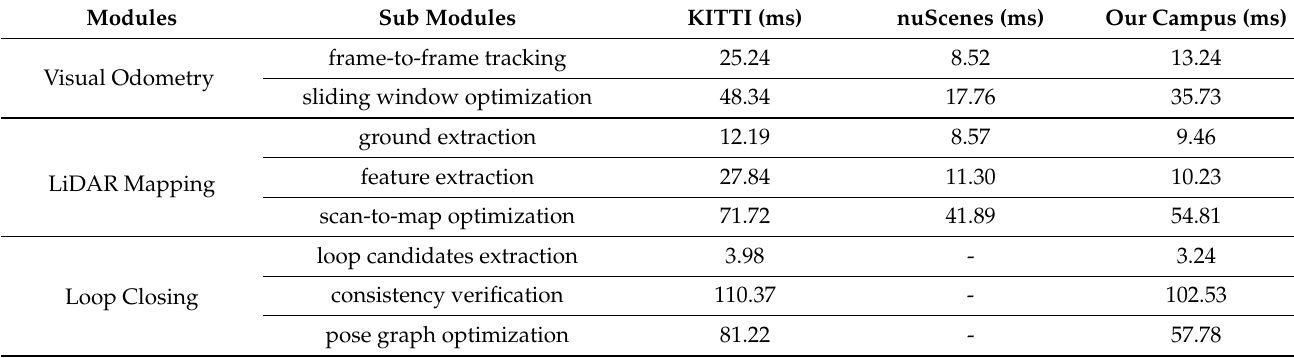
Table 6. Average processing time of each module on the KITTI, nuScenes, and Our campus dataset.